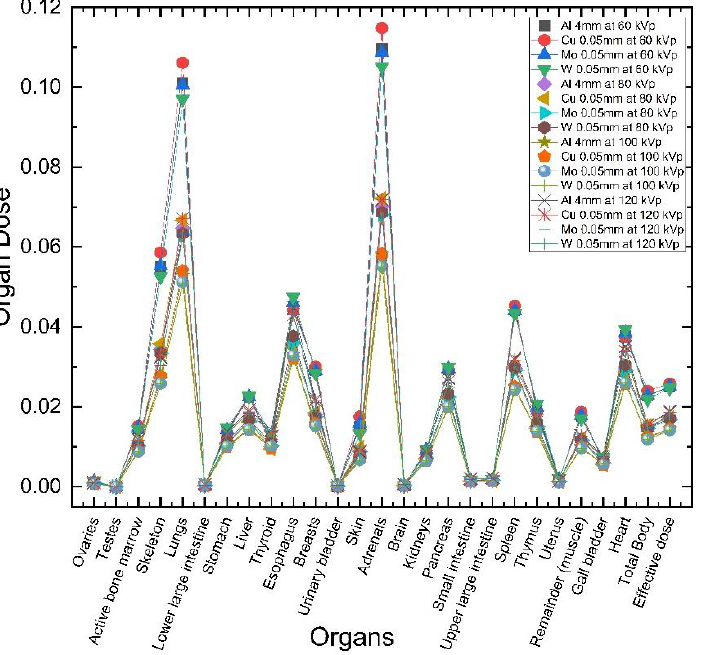
Figure 3. Organ absorbed dose result using various filters (Al, Cu, Mo, W, and no filter) at 60, 80, 100, and 120 kVp .